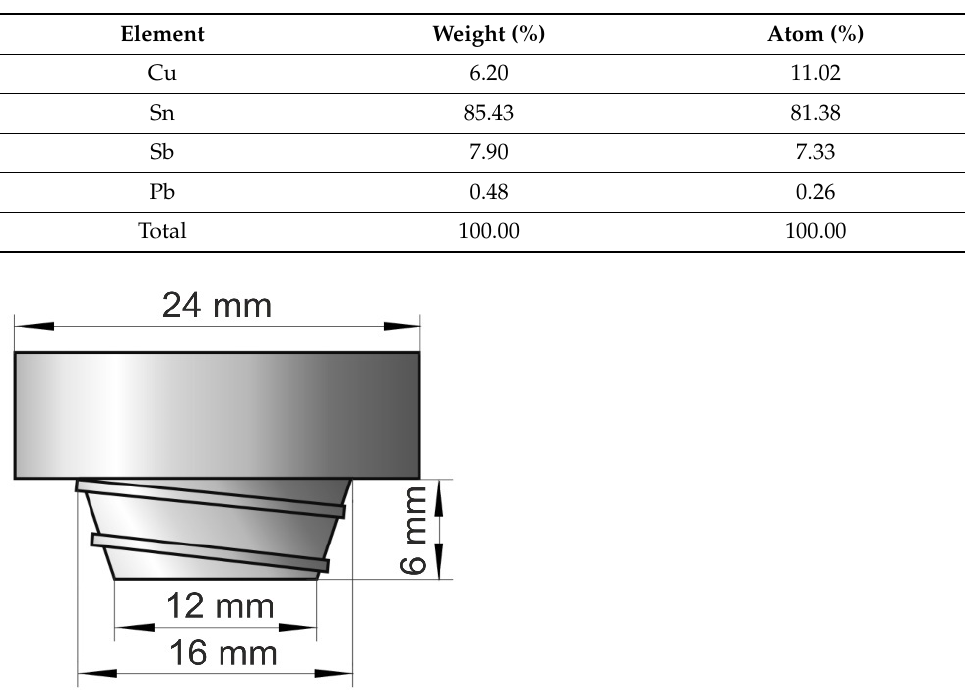
ball with a diameter of 2.5 mm and a load of 31.25 kg were used. The average hardness